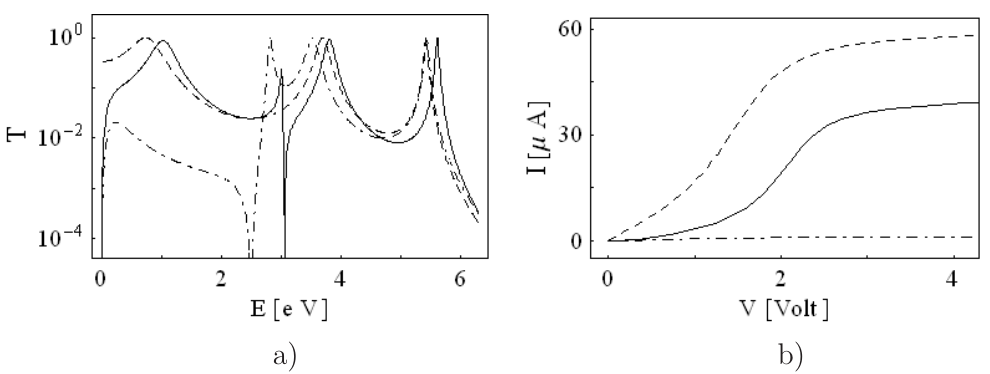
Fig. 2 (a) Transmission-energy functions T ( E ) = T ( − E ) and (b) current-voltage characteristics I ( V ) = − I ( − V )for devices with bridges: x (broken line), y (solid line) and z (dotted-dashed